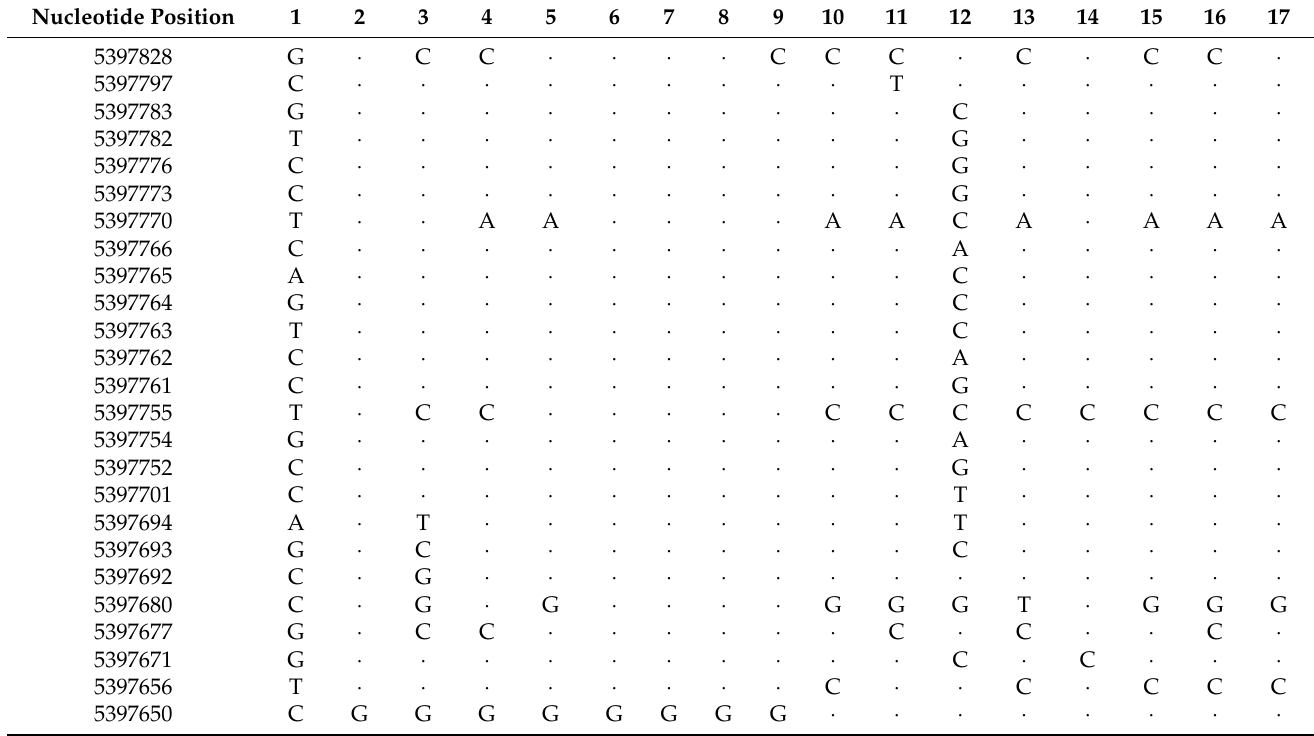
Table interpretation. 1: M. fortuitum subsp. fortuitum ATCC 6841; 2: M. fortuitum subsp. acetamidolyticum ATCC 35931; 3: M. alvei CIP 103464; 4: M. boenickei CIP 107829; 5: M. brisbanense DSM 44680; 6: M. conceptionense CIP 108544; 7: M. farcinogenes DSM 43637; 8: M. houstonense ATCC 49403: 9: M. neworleansense ATCC 49404; 10: M. peregrinum ATCC 14467; 11: M. porcinum DSM 44242; 12: M. senegalense ATCC 35796; 13: M. septicum ATCC 700731; 14: M. setense CIP 109395; 15: M. arceuilense DSM 46715; 16: M. lutetiense DSM 46713; 17: M. montmartrense DSM